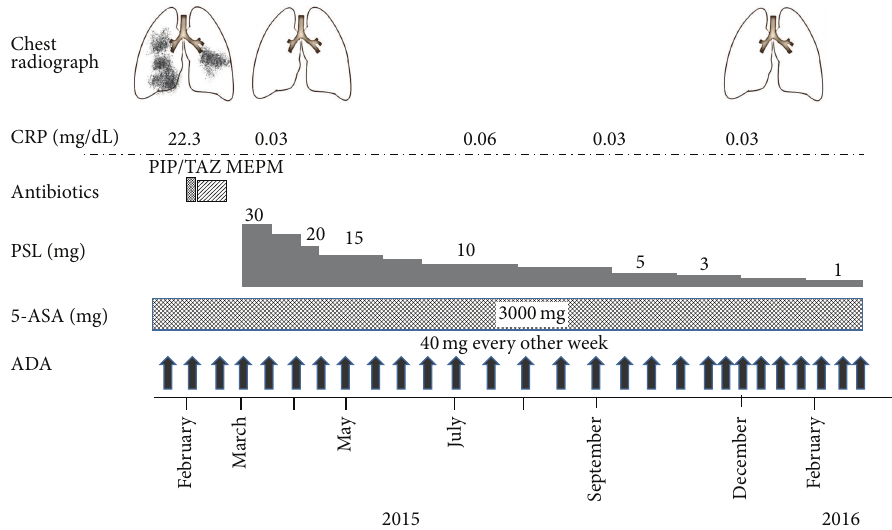
Figure 3: The clinical course of the patient, a 64-year-old man with Crohn’s disease. Progressive pulmonary symptoms and manifestations were seen during scheduled ADA maintenance therapy. Treatment with prednisolone induced rapid, sustained improvements. CRP: C-reactive protein; PIP/TAZ: piperacillin/tazobactam; MEPM: meropenem; PSL: prednisolone; 5-ASA: 5-aminosalicylic acid; ADA: